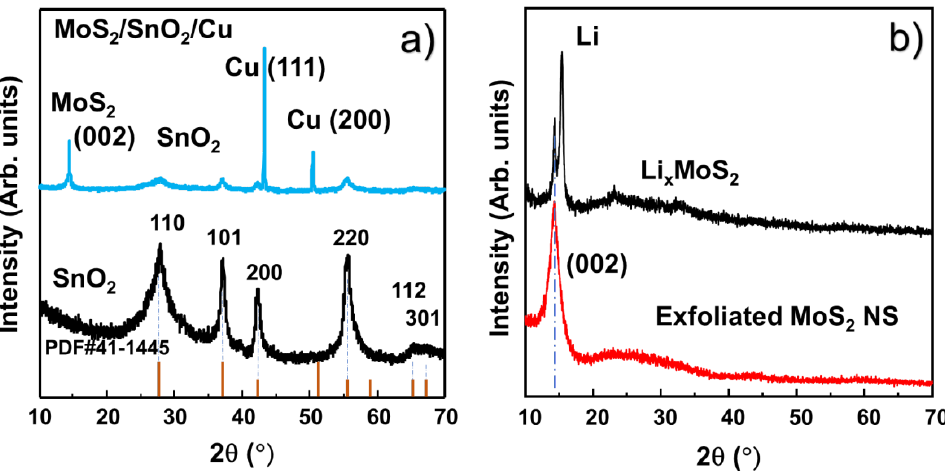
Figure 3. X-ray diffraction (XRD) patterns of ( a ) SnO 2 NPs and M3SnO 2 anode and ( b ) lithium-ion intercalated and exfoliated MoS 2 nanosheet.